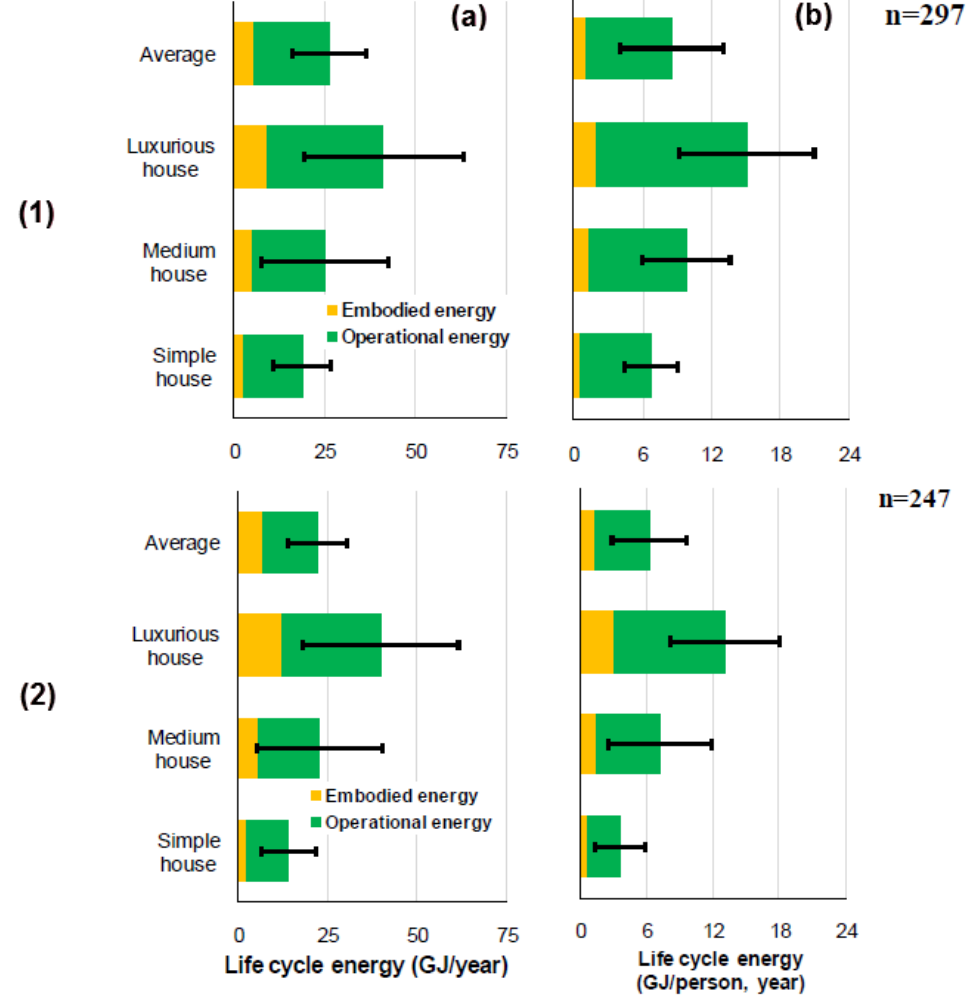
Figure 9. Average annual life cycle energy for respective house categories in ( 1 ) Jakarta and ( 2 ) Bandung for Scenario 1. ( a ) Total life cycle energy and ( b ) unit life cycle energy (per person). Note: The error bars indicate the mean values ± standard